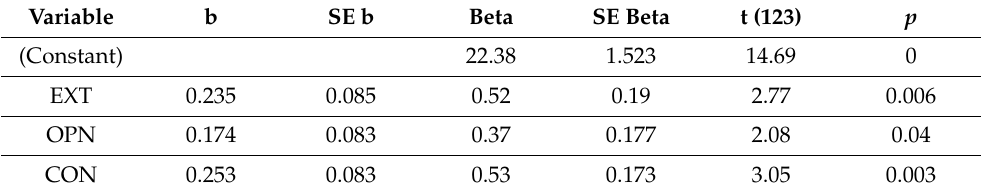
Table 6. Regression analysis in the female group for dependent variable general